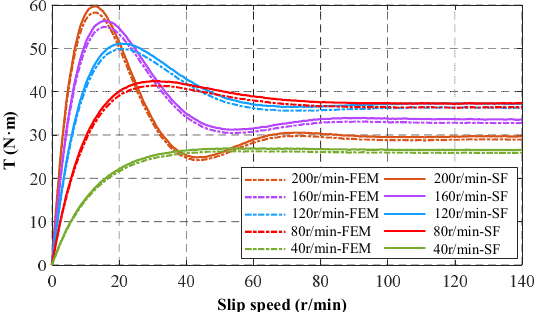
Figure 19. Transient torque response of the HTR-ASD under different slip speeds and an excitation current of 6A.